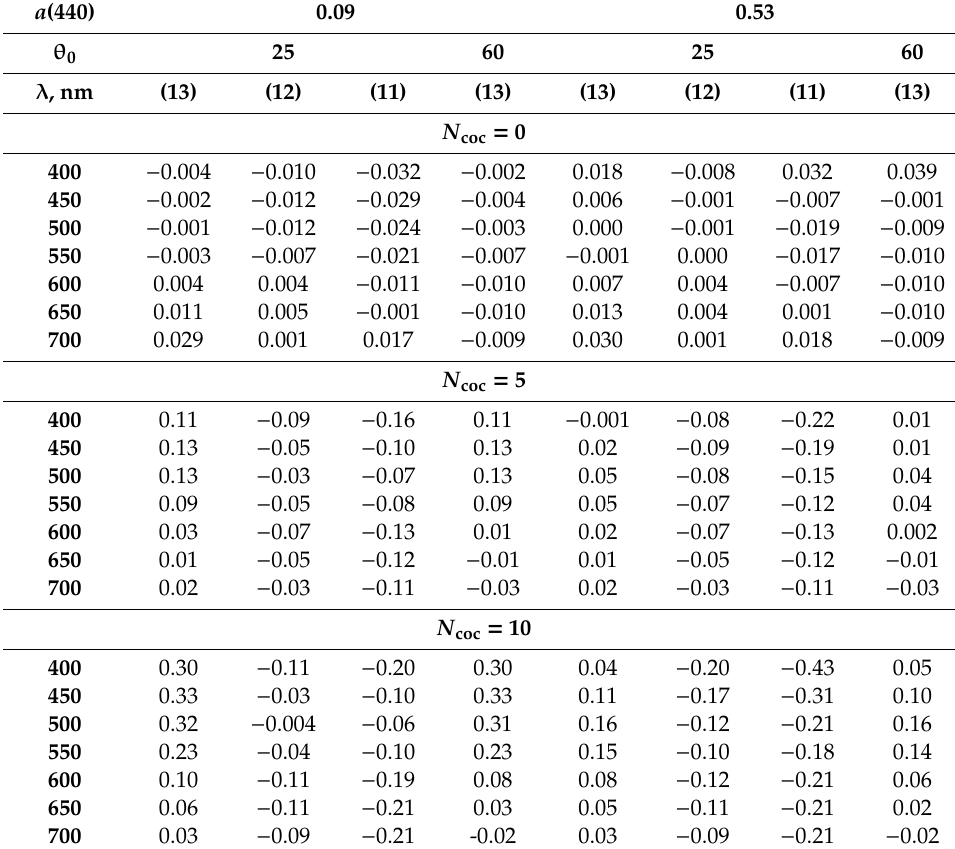
Table 8. The absolute errors (m − 1 ) of the Equations (11–13) for determining < K > , depending on the value of N coc (10 6 cell / L), the solar zenith angle θ 0 ( ◦ ), and the absorption coe ffi cients a (440), m − 1